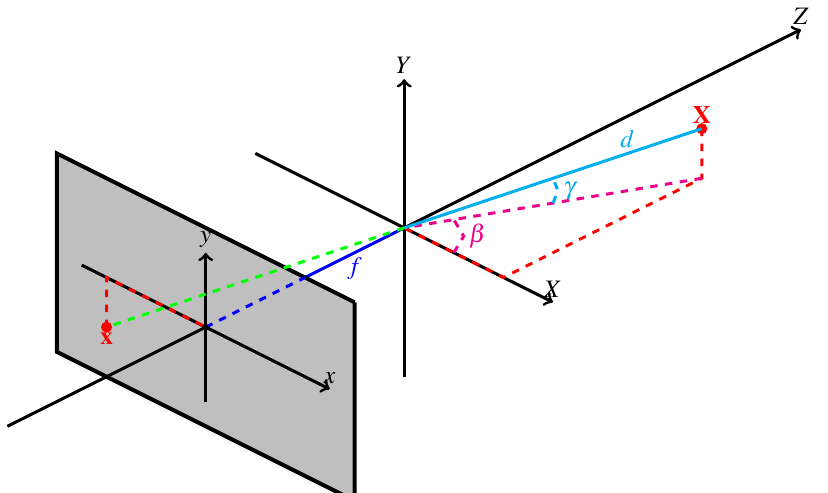
Figure 1. The pinhole camera model. A point X is projected on the image plane in x . d is the distance from X to the camera center. β and γ are the azimuthal and polar angles of the ray from X through the optical center, respectively. f is the focal length of the